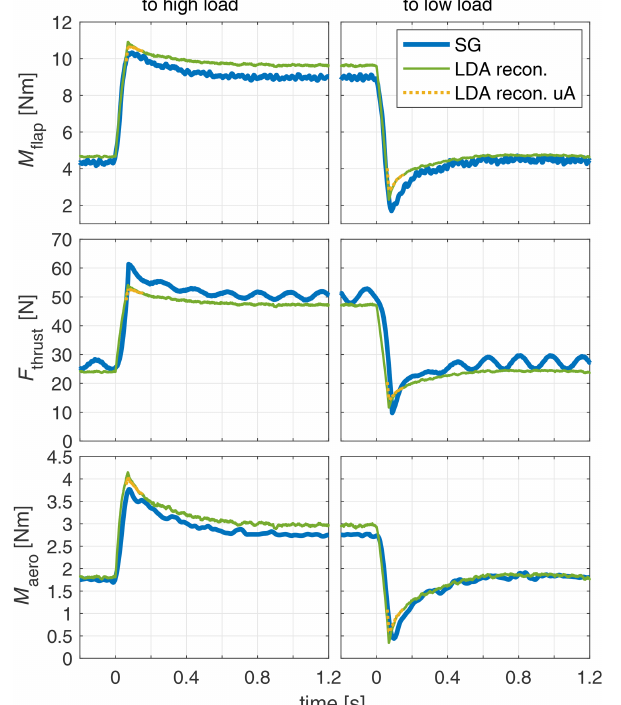
Figure 19. Integral turbine loads based on strain gauges with (SG) and without (SG no corr.) the dynamic corrections (as introduced in Sect. 2.1.5) and reconstructed loads based on Blade Element Theory from the LDA measurements without and with uA